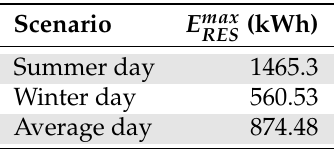
Figure 4. Solar PV generation for three representative days in the Netherlands. Table 5. Maximum PV generation over each representative scenario.